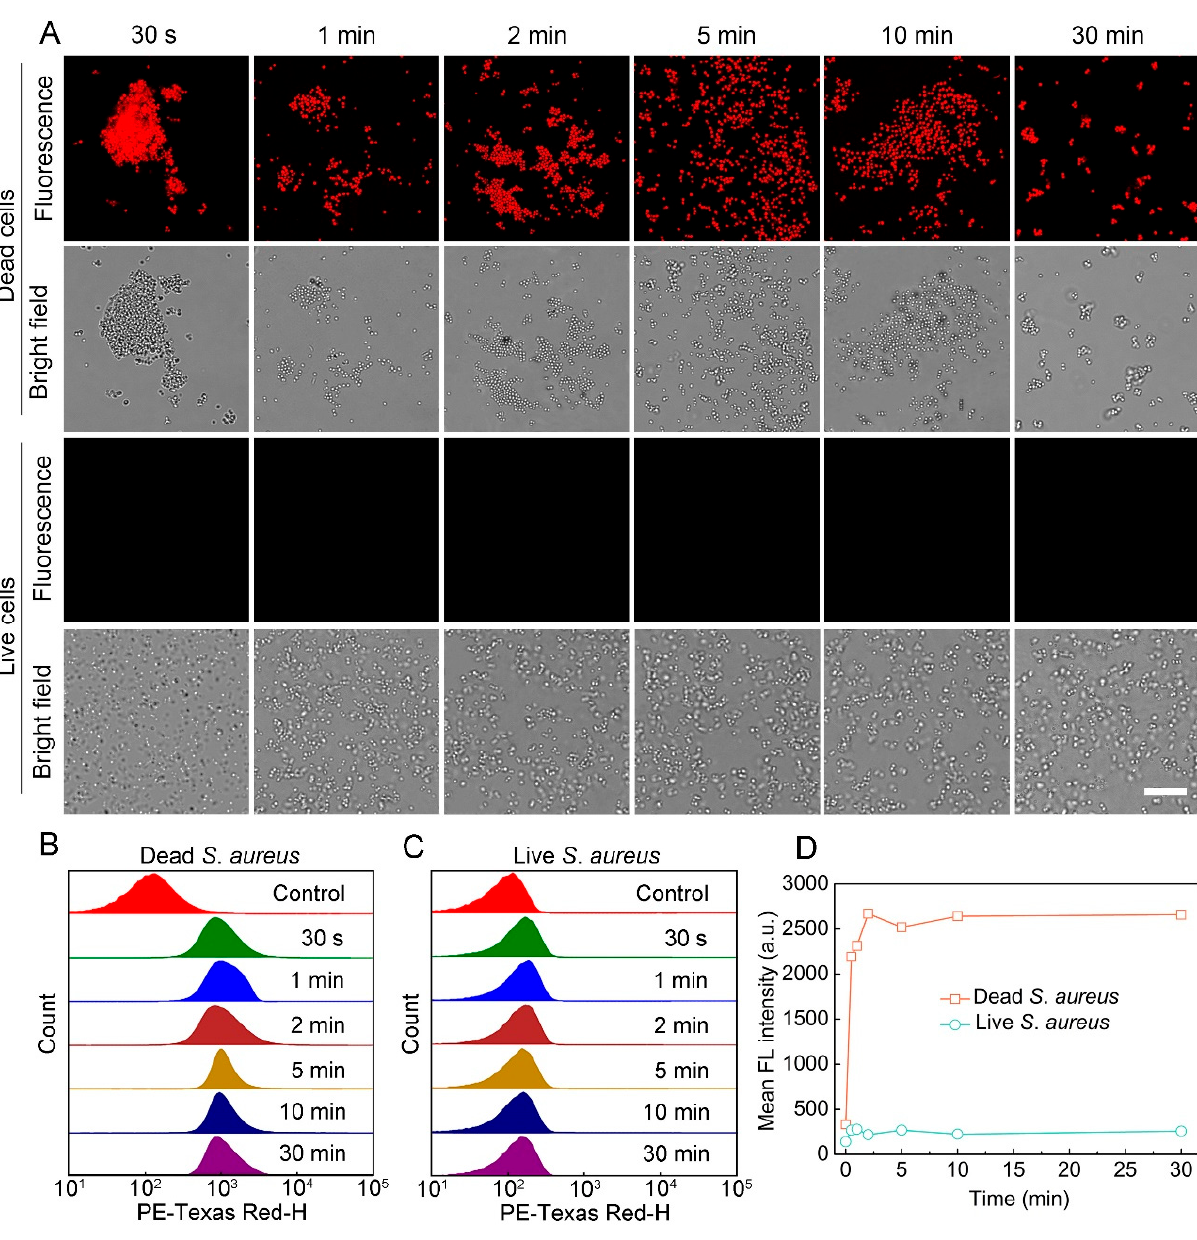
Figure 4. ( A ) Confocal images of dead and live S . aureus cells treated with S-OSiNDs (5 µ g/mL) for different time periods. Scale bar = 10 µ m. Flow cytometric results of the dead ( B ) and live ( C ) S . aureus cells incubated without (control) or with S-OSiNDs (5 µ g/mL) for different time periods and ( D ) corresponding quantitative mean fluorescence intensities derived from the flow cytometric re- sults.